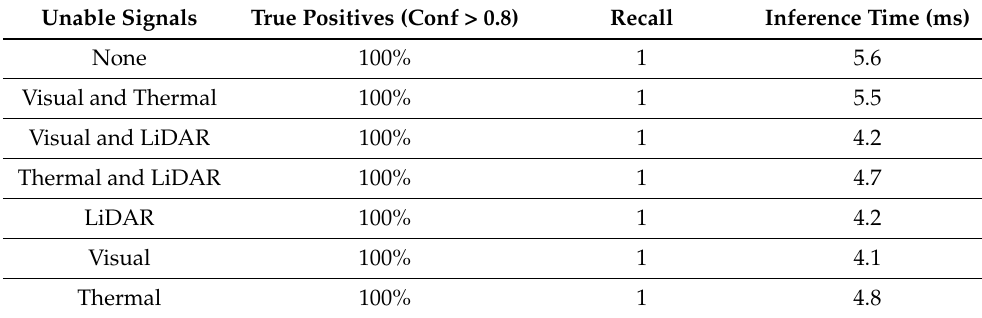
Table 4. Performance over 18 images during a landing operation for different unable